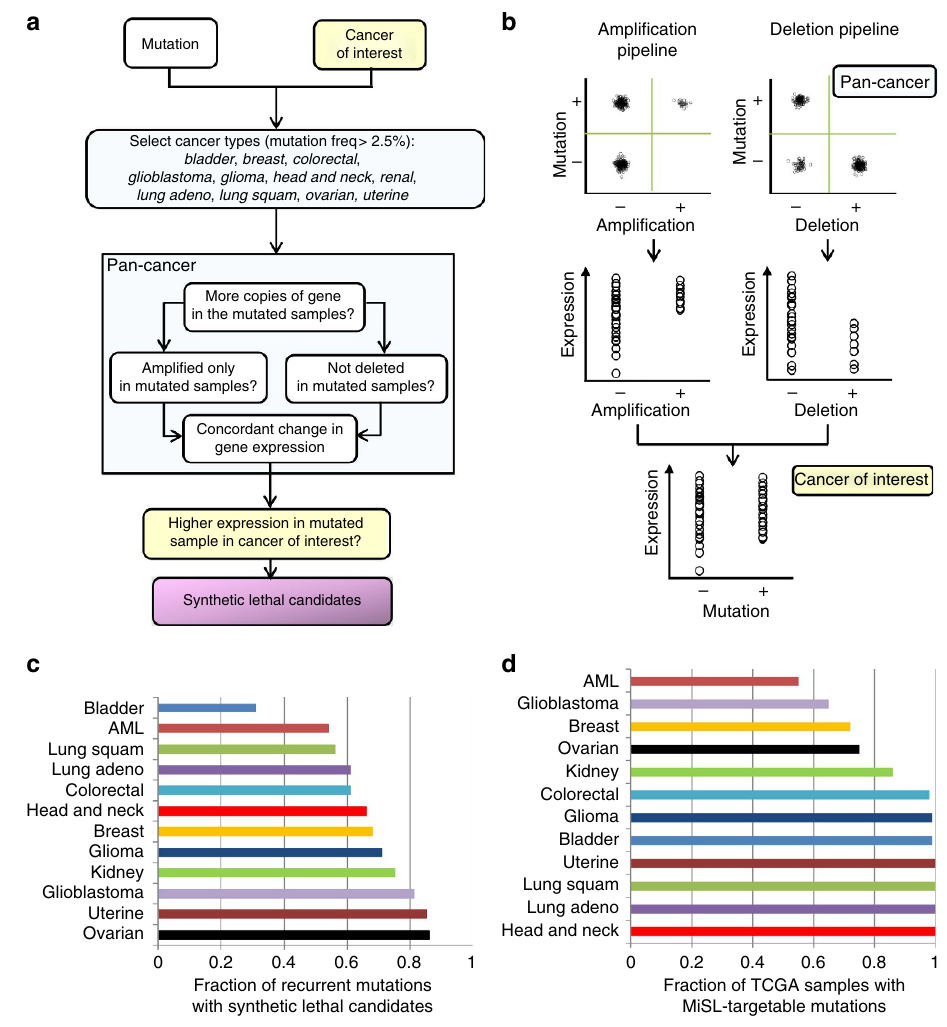
Figure 1 | The MiSL algorithm. ( a ) Pipeline of MiSL algorithm: For a given mutation and a cancer of interest, the pipeline outputs a list of genes, which are the candidate SL partners or MiSL candidates of the mutation in the cancer of interest. ( b ) Depiction of the various steps through the deletion pipeline and amplification pipeline in MiSL. ( c ) Fraction of recurrent mutations with SL candidates in each of the 12 TCGA cancers. ( d ) Fraction of TCGA samples with MiSL-targetable mutations in each of the 12 TCGA